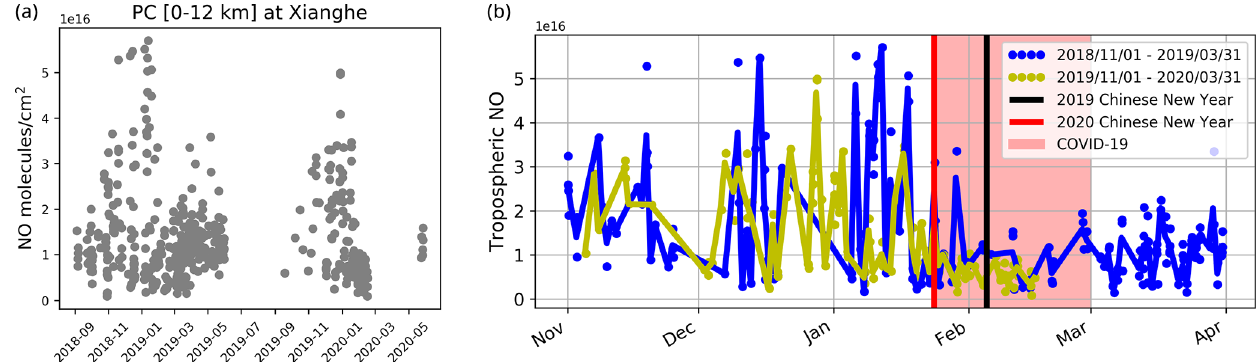
Figure 11. (a) The time series of the FTIR-retrieved tropospheric NO partial columns at Xianghe. (b) The time series of FTIR-retrieved tropospheric NO partial columns during November 2018–March 2019 and November 2019–March 2020. The blue and yellow dots are individual measurements, and the solid lines are daily means.